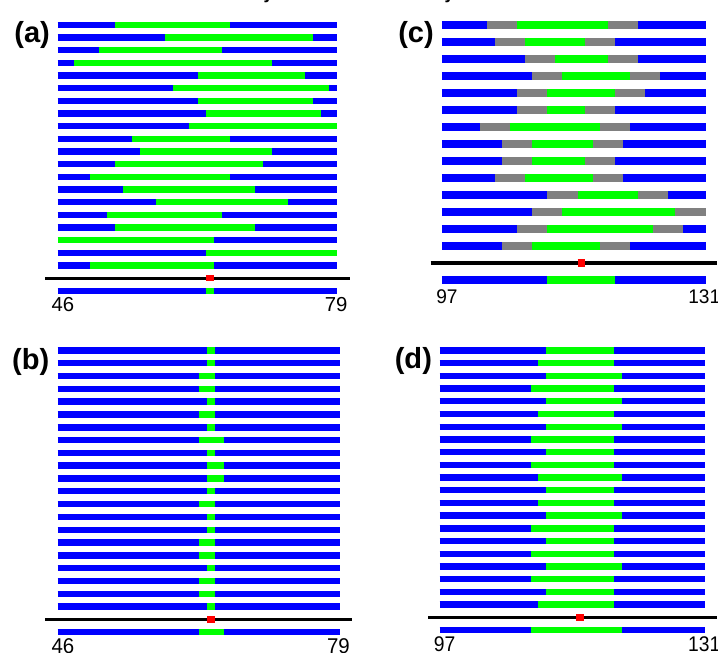
Figure 10. A bar represents the correlation profile in the range of orientation as marked below each figure (green: positive, blue: negative, gray: null); a negative correlation is implied for the rest of the space. The results of conjunction or disjunction are shown below the black line in each figure, while the red mark on each black line shows the instance of orientation presented for simulation. The data for ( a , b ) were drawn from a run when entire orientation space was divided into negative and positive correlations, while for ( c , d ), the null range was also included. ( a , c ) show the result of a conjunction of profiles of active LL agents mapped to an HL agent, while ( b , d ) shows the results of the disjunction of such conjunctions. The list of terms in disjunction may not be exhaustive, even though the result is the same. The activation limit was 0.4, i.e., 40 percent of input connections had to be active to activate the HL